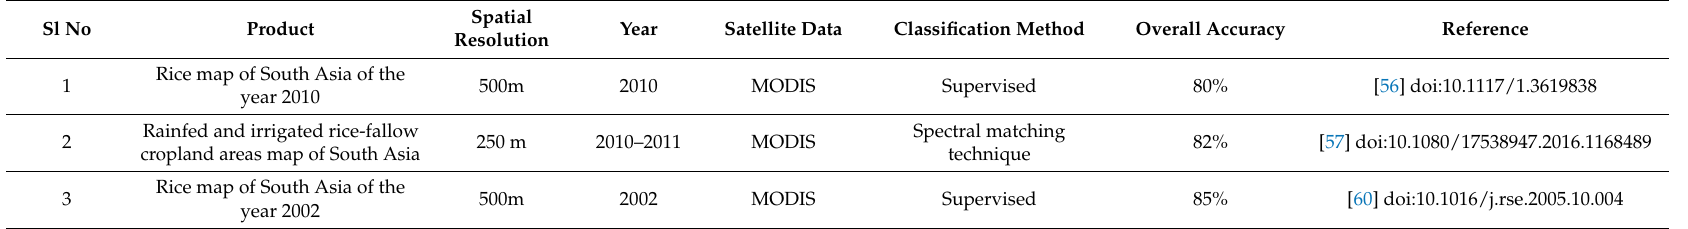
Table 3. Summary of the available regional land cover and cropland